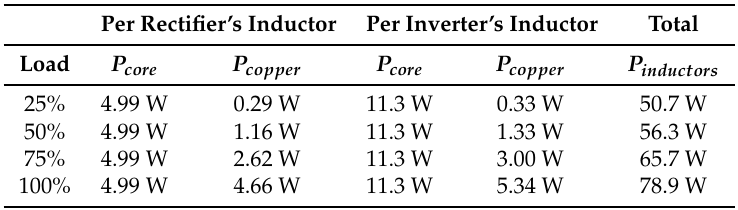
Table 6. Losses calculated for